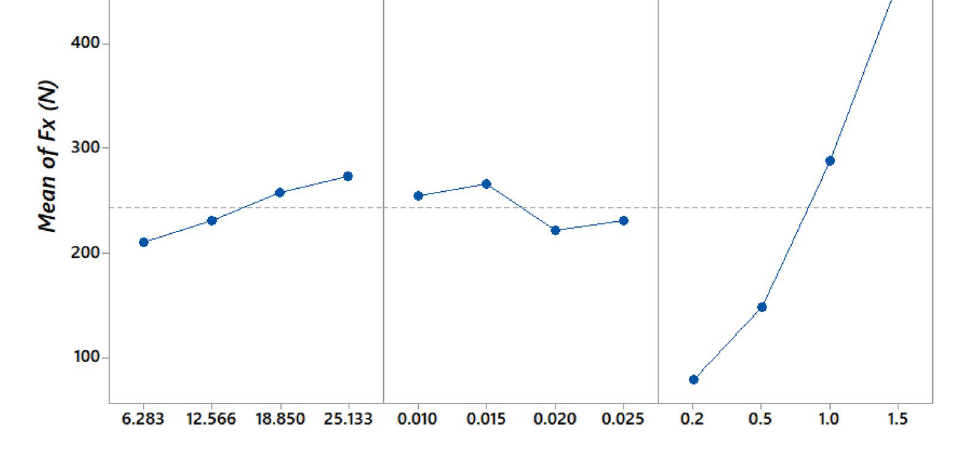
Fig. 3 main effect plot of F z for SiCp/Al 45%